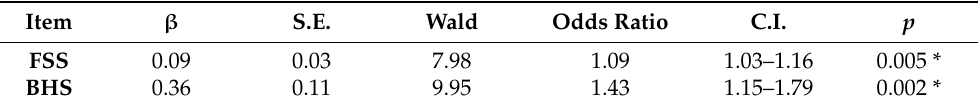
Table 3. Associated factors of depressive disorder among patients at the 12-month follow-up: logistic regression